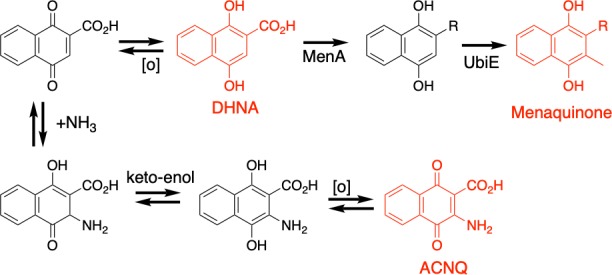
Proposed mechanism for the non-enzymatic conversion of DHNA to ACNQ.Initiated by oxidation of DHNA then conjugate addition of ammonium at the C3 position followed by enol formation and subsequent oxidation of the hydroquinone.